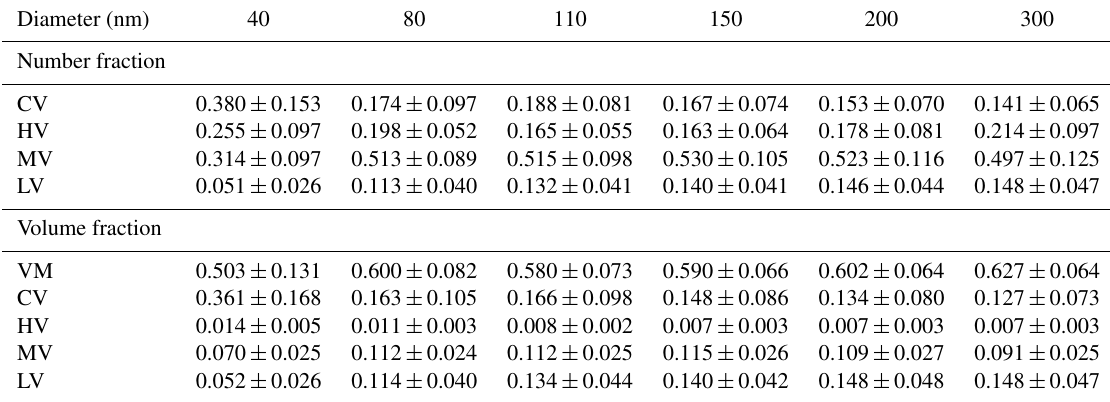
Table 2. Summary of average number and volume fractions in VTDMA measurements at 300 ◦ C. Diameter